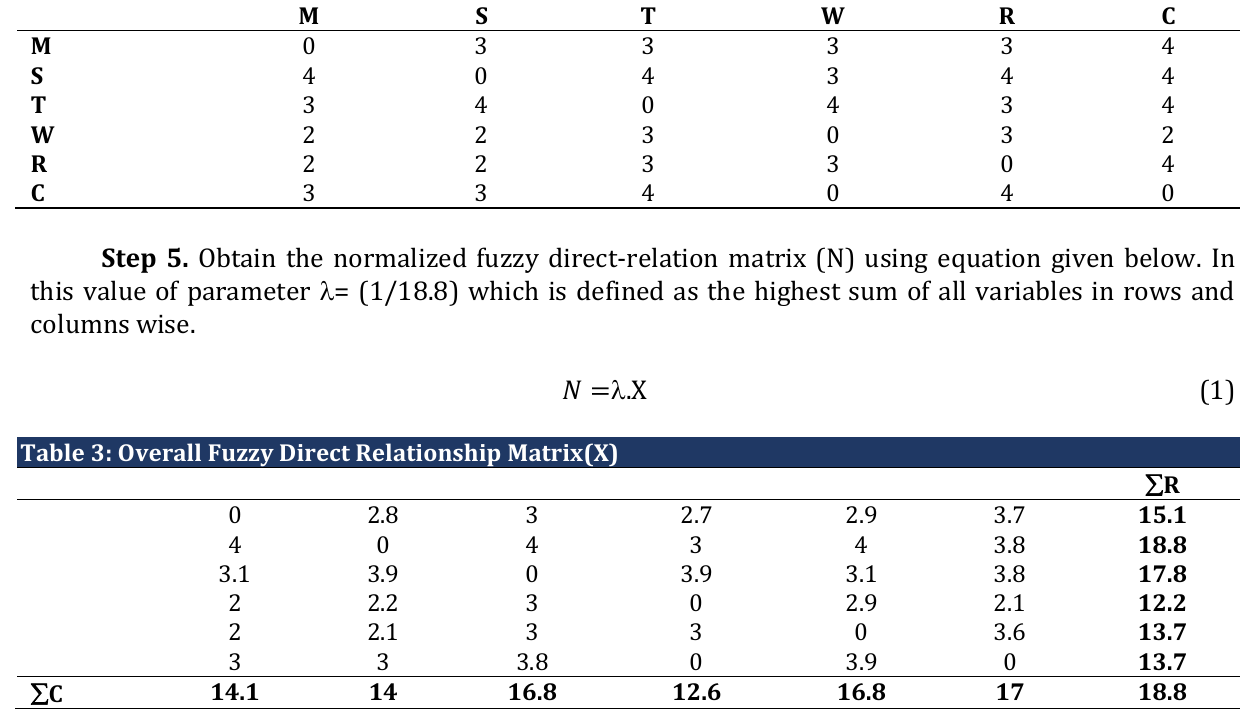
Table 2: Initial direct relation matrix